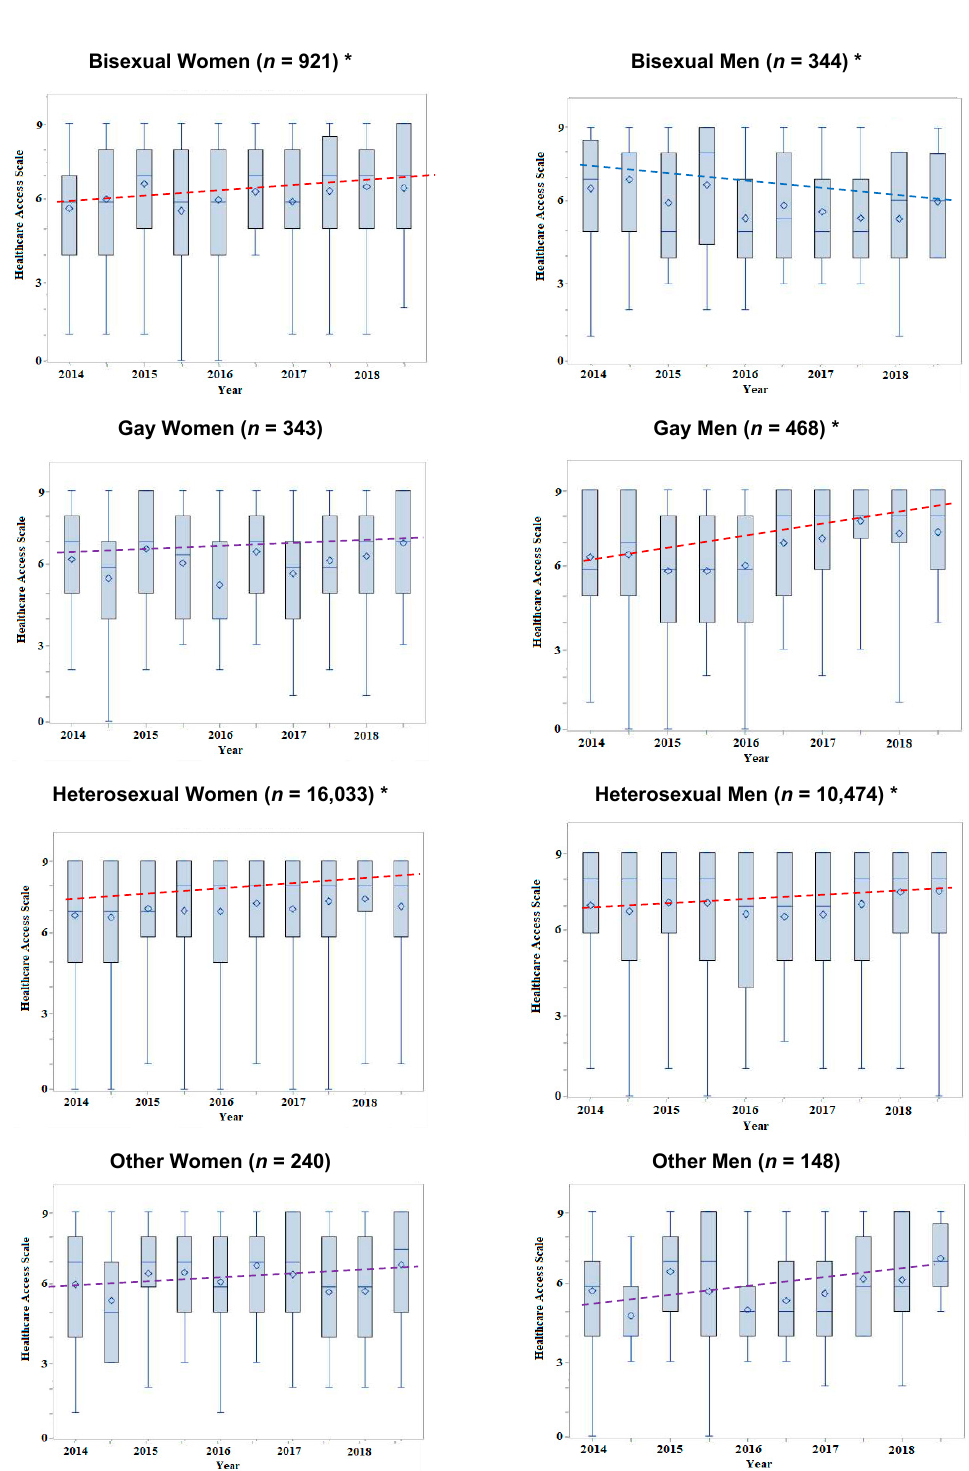
Figure 1. Box plots of health care access scale over time across sexual identity and sex ( n = 28,463). * Statistically significant trend ( p < 0.05) using Spearman rank-sum correlation. Dotted lines are linear trendline estimates. Purple lines are not statistically significant. Blue lines are sighificant decrease, and red lines are a significant increase. Boxes represent 1st quartile (bottom), median (center), mean (diamonds), and 3rd quartile